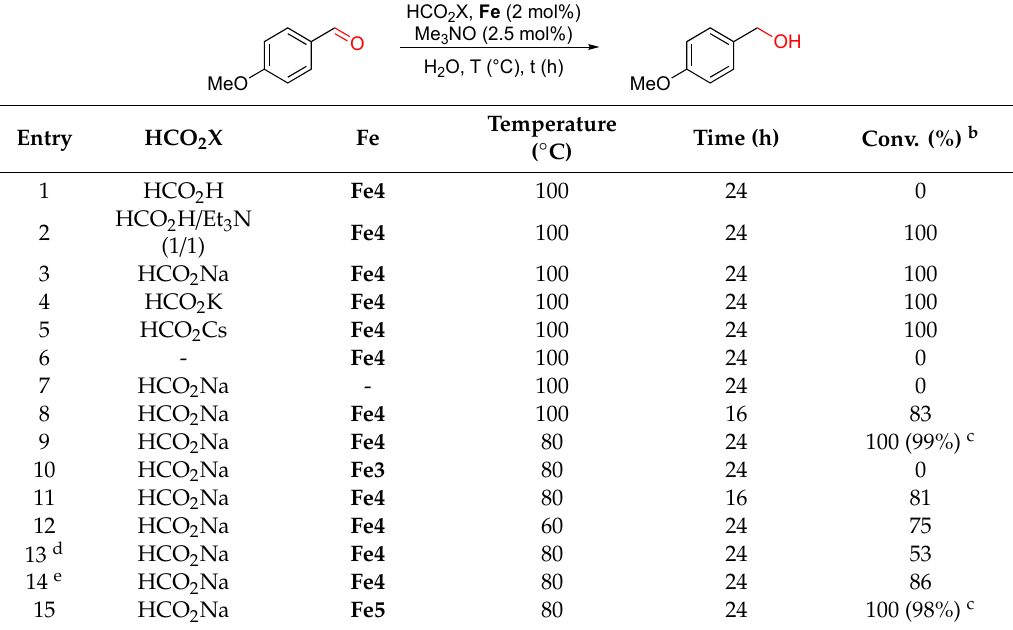
a General conditions: HCO 2 X (5 mmol, 5 equiv.), 4-methoxybenzaldehyde (1 mmol), pre-catalyst (2 mol %), Me 3 NO (2.5 mol %), water (2 mL). b Conversion was determined by 1 H-NMR spectroscopy analysis. c Isolated yield in